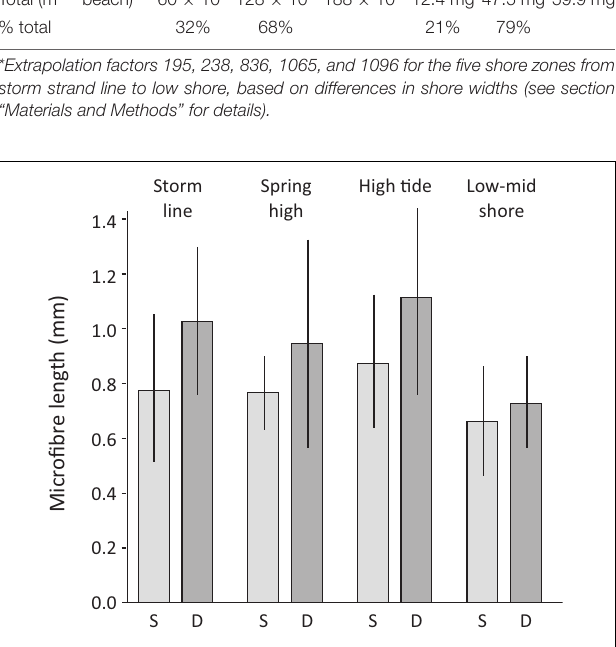
mass of microfibers, and the low and mid-shore accounting for 84% of the mass ( Table 4